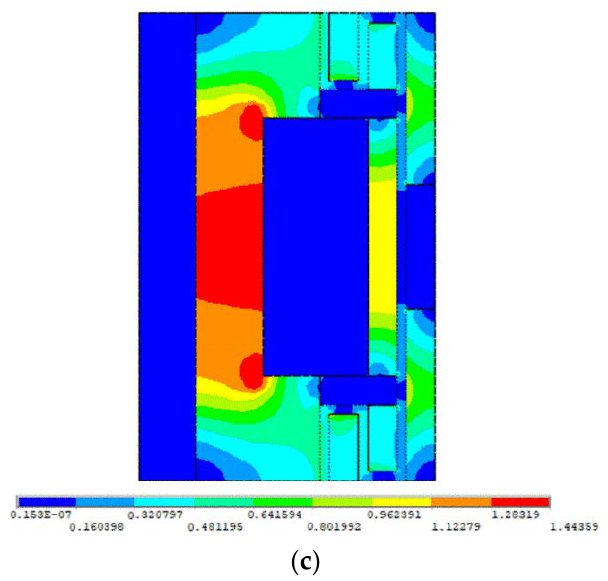
Figure 5. Magnetic characteristics of the initial MR damper [31]. ( a ) Axisymmetric model for the FEA. ( b ) Magnetic flux. ( c ) Contours of the magnetic flux density.